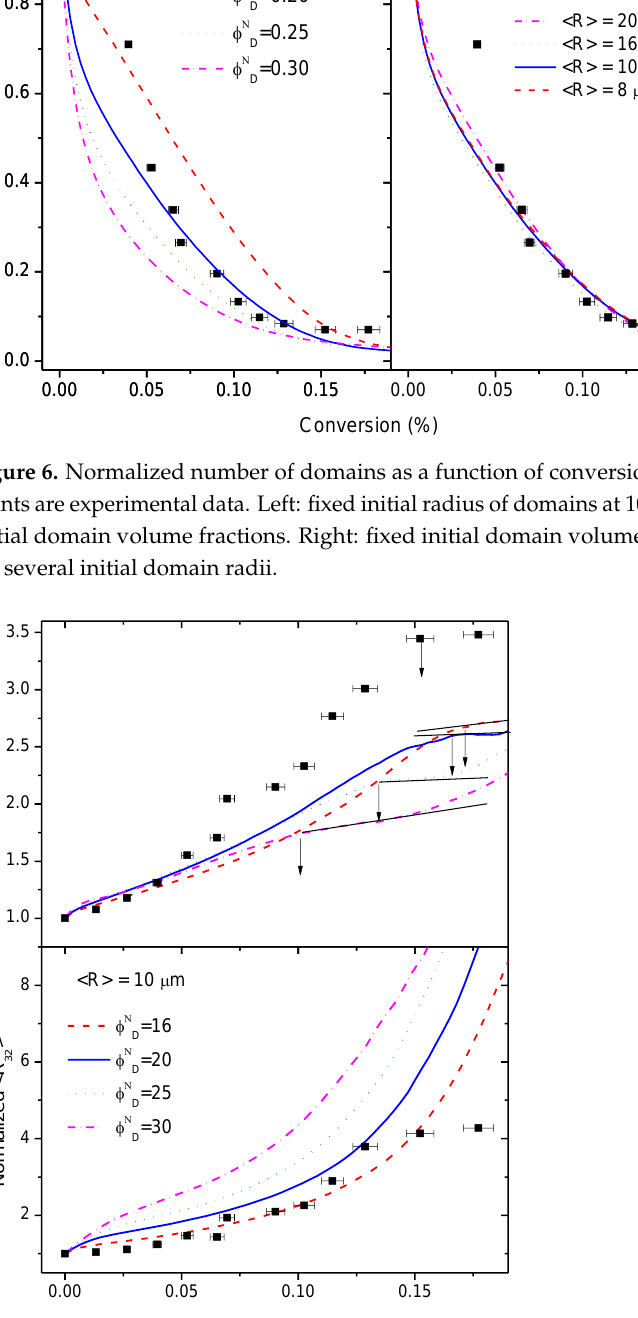
Figure 7. Normalized average diameter, (cid:104) R (cid:105) / (cid:104) R (cid:105) , (up) and Sauter diameter, (cid:104) R 32 (cid:105) / (cid:104) R 32 (cid:105) (bottom) 0 0 Figure 7. Normalized average diameter, 〈𝑅〉/〈𝑅〉 0 , (up) and Sauter diameter, 〈𝑅 32 〉/〈𝑅 32 〉 0 (bottom) as a function of conversion for several initial domain volume fractions fixing the initial average size as a function of conversion for several initial domain volume fractions fixing the initial average size in 10 µ m. Square points are experimental data. Continuous black lines (up) show the plateau in in 10 μm. Square points are experimental data. Continuous black lines (up) show the plateau in average diameter; arrows show the conversion at which the plateau starts. average diameter; arrows show the conversion at which the plateau starts .